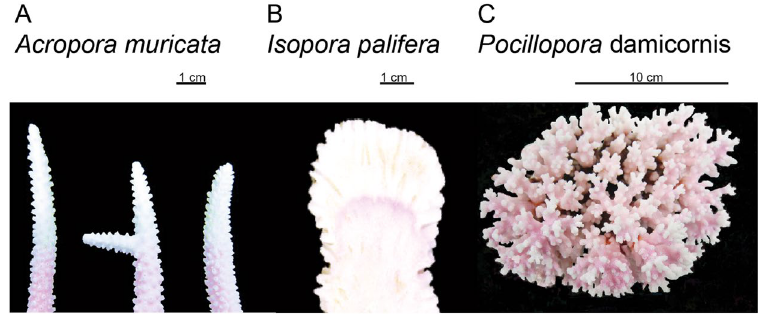
Figure 2. Coral species ( A ) Acropora muricata , ( B ) Isopora palifera and ( C ) Pocillopora damicornis utilized in this study. The pink portion of the skeleton is the result of the Alizarin Red dye being incorporated into the skeleton from staining and the white portion is the newly accreted